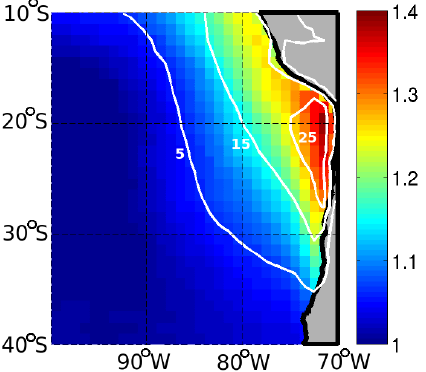
Fig. 2. The ratio of time-mean albedo calculated with the observed N d to the mean albedo calculated with the typical marine N d is shown by the colored contours. To calculate the denominator the observed N d over time at each point in space is replaced with the average time series of N d in a domain of 30–40 ◦ S, 90–100 ◦ W, an area more “pristine” than near the coast providing a good rep- resentation of clean marine air. The white contour lines show the time mean of the difference between a diurnal mean estimate of the reflected solar flux and the same flux computed using the typical marine N d . The numbers indicate W m − 2 of flux difference due to the different values for N d .